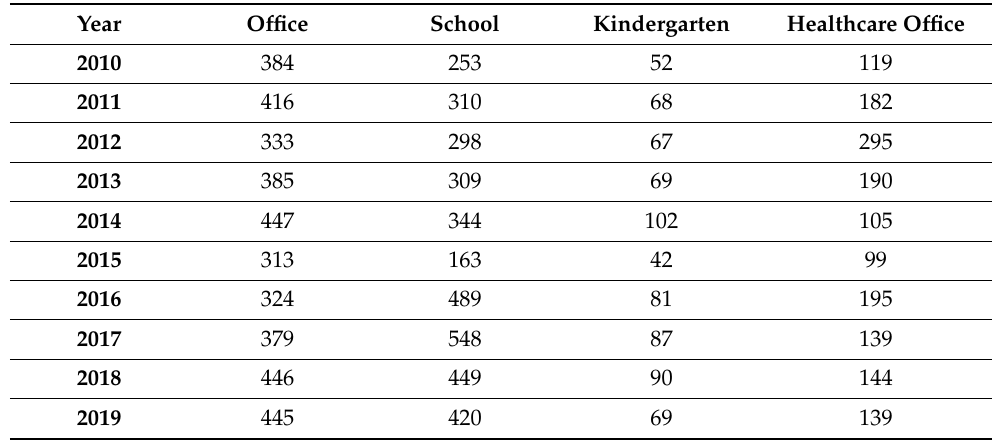
Table 1. The yearly numbers of VOC ( a ) and formaldehyde ( b ) samples collected from office, school, kindergarten, and healthcare office